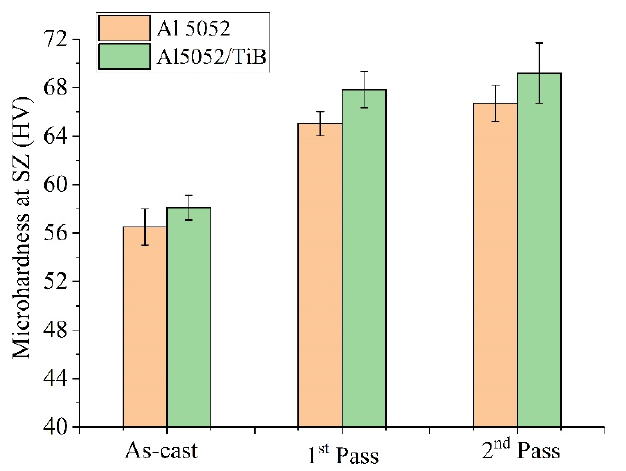
Figure 6. Microhardness of the investigated alloys in the as-cast state and FSP after first- and second-pass friction stir processing.